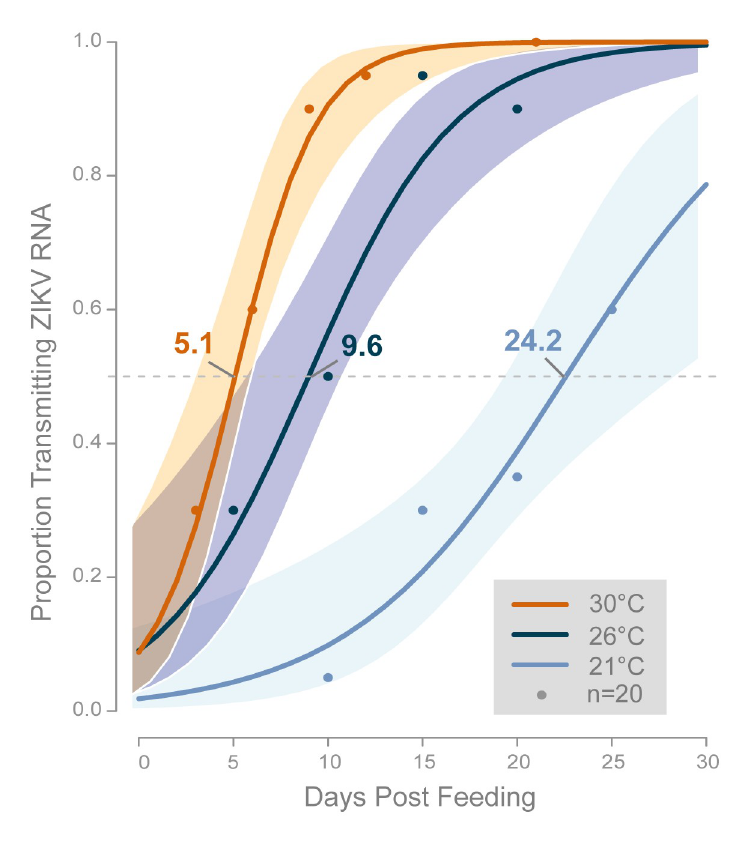
Fig 3. Fitted logistic curves showing the proportions of Ae . aegypti transmitting ZIKV vRNA over time by temperature. Each point represents the observed proportion of mosquitoes (of 20 tested) that transmitted at each temperature and time-point. The estimated EIP 50 is indicated for each